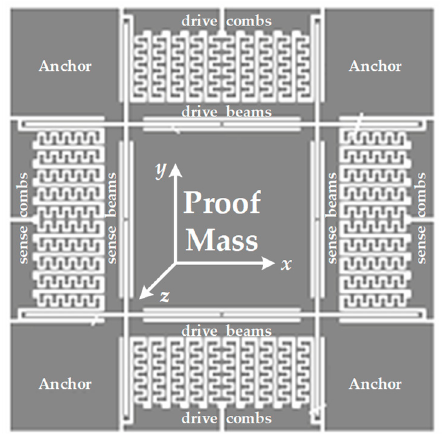
Figure 1. A standard model of the sensitive structure for micro-electromechanical systems (MEMS) gyroscopes.